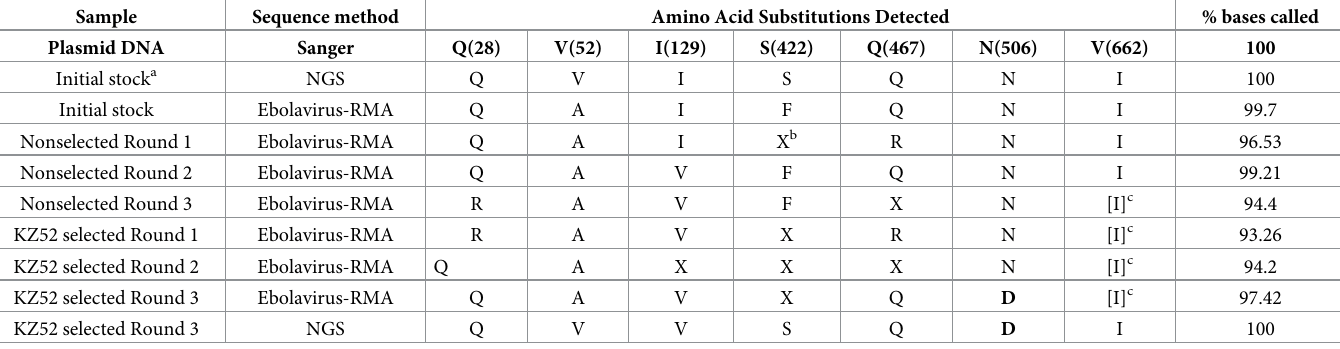
and NGS in the full-length genome samples. All the microarray data from the replicating recombinant virus study is available at ArrayEx- press (https://www.ebi.ac.uk/arrayexpress/) with the accession number E-MTAB-10008. Table 3. Recombinant virus, rVSV-EBOVgp-GFP, point mutations identified by Ebolavirus-RMA sequencing. RNA was extracted from virus stock cultured with (selected) or without (nonselected) Ebola virus neutralizing antibody